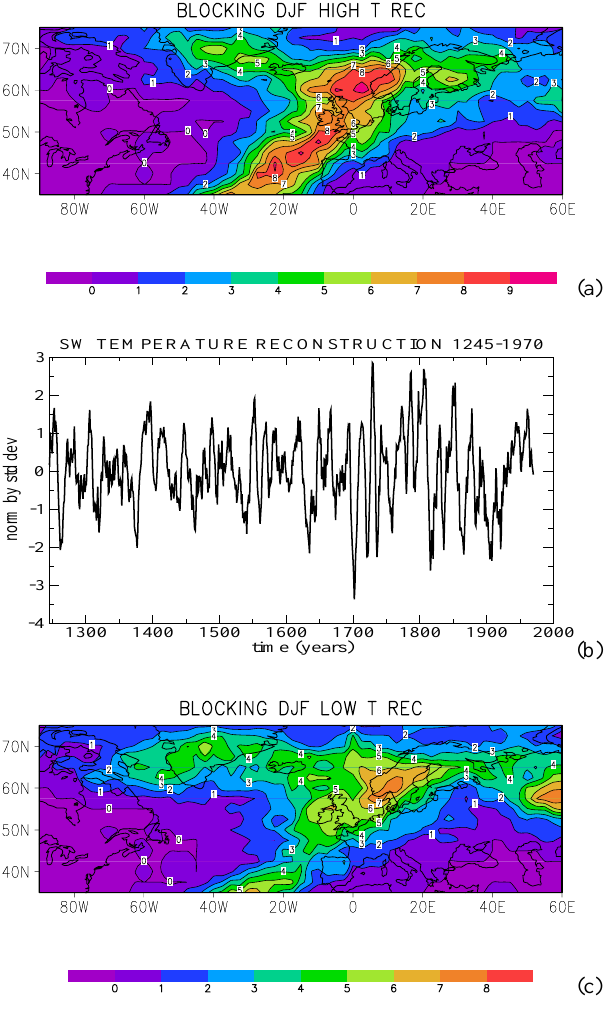
Fig. 9. Composite map of winter blocking corresponding to (a) high and (c) low values of Greenland temperature reconstruction based on stable isotopes records from Greenland ice-cores (Vinther et al., 2003) represented in (b) .